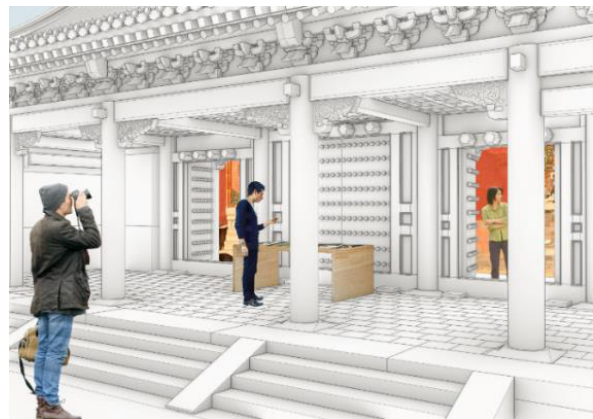
Figure 36. The booth in front of Long-en